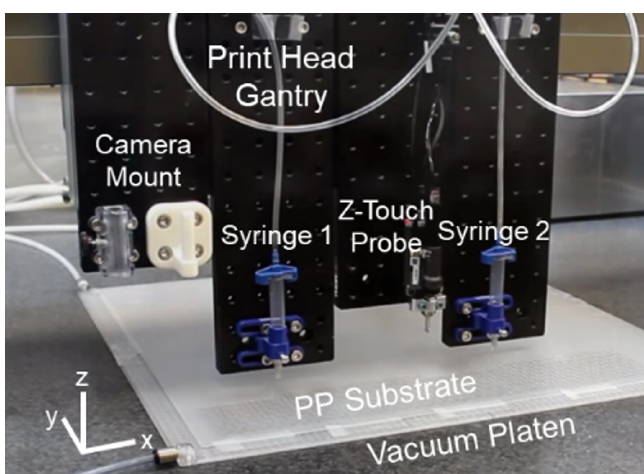
Figure 6. Origami FSS fabrication setup. Image of Aerotech gantry print head with camera mount, touch probe and dual syringe attachments. A custom vacuum platen was employed to improve uniformity in the z-height of the polypropylene (PP) substrate.